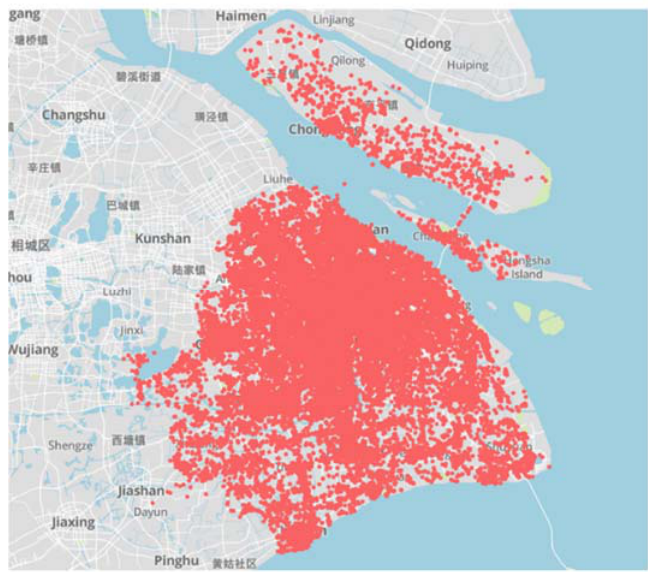
Figure 2. Spatial distribution of data samples.